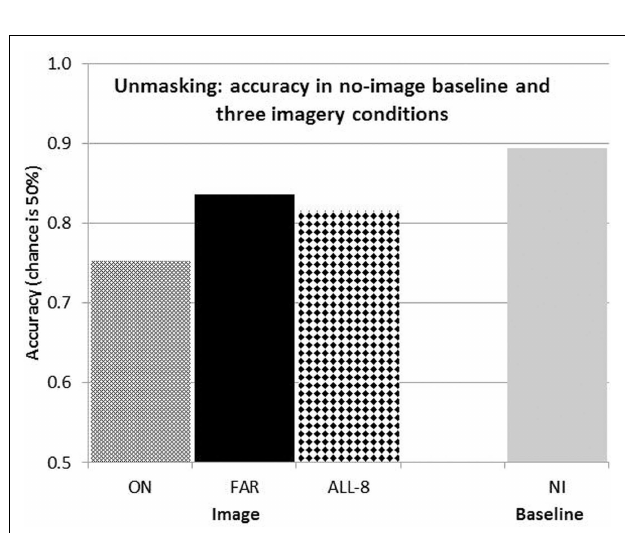
FIGURE 3 | Mean correct performance for the acuity task with ON and FAR images, each of four lines, withALL eight imagined lines, and in the baseline no image